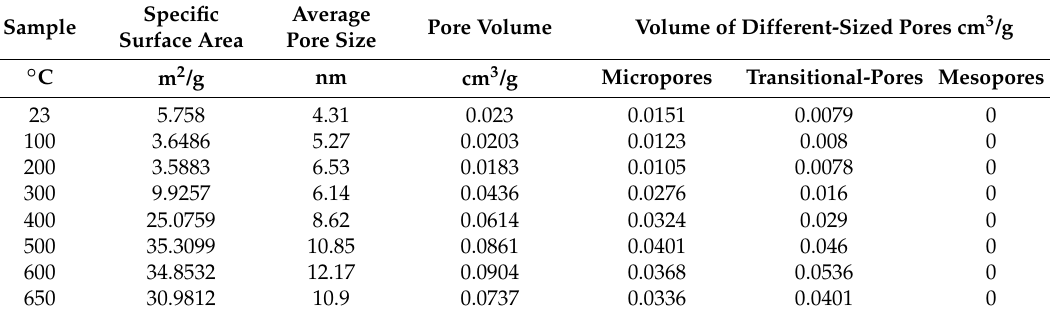
Table 2. Low-pressure nitrogen adsorption (LPNA) pore structure characteristic